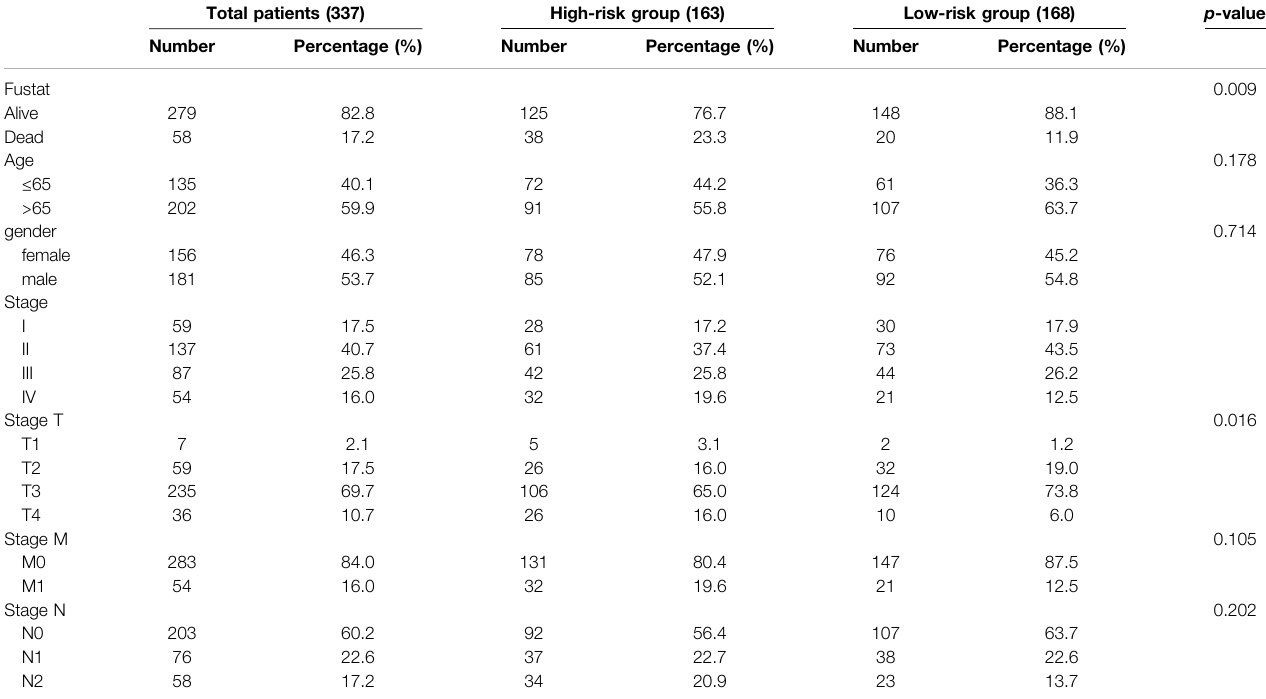
TABLE 1 | Clinicopathological features of patients included in this